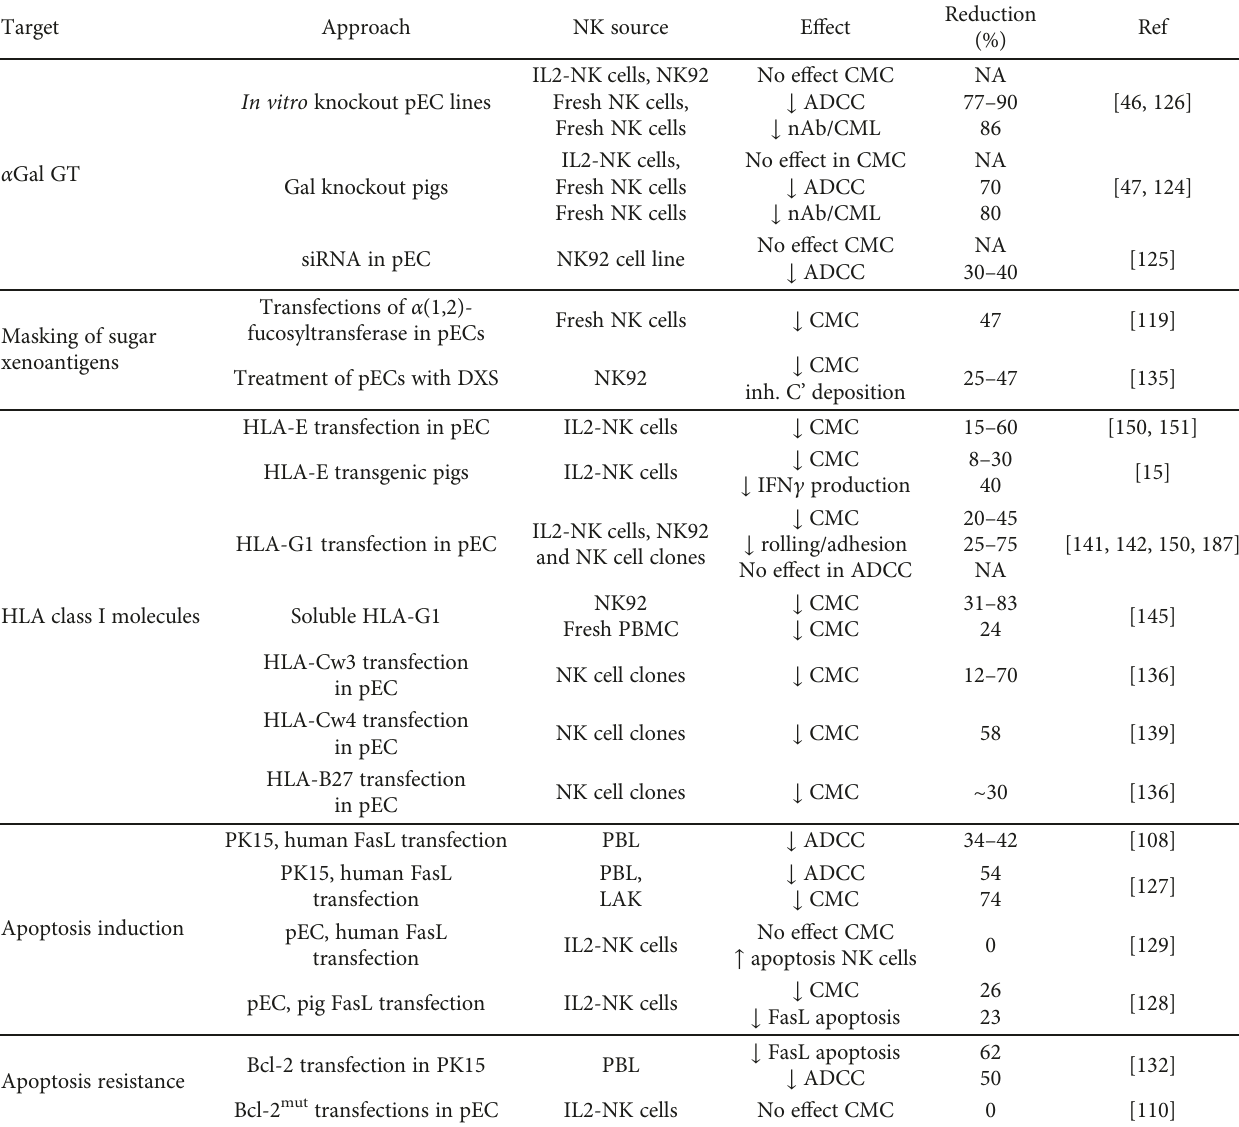
Table 2: Proven strategies to overcome NK cytotoxicity against pig endothelial cells.